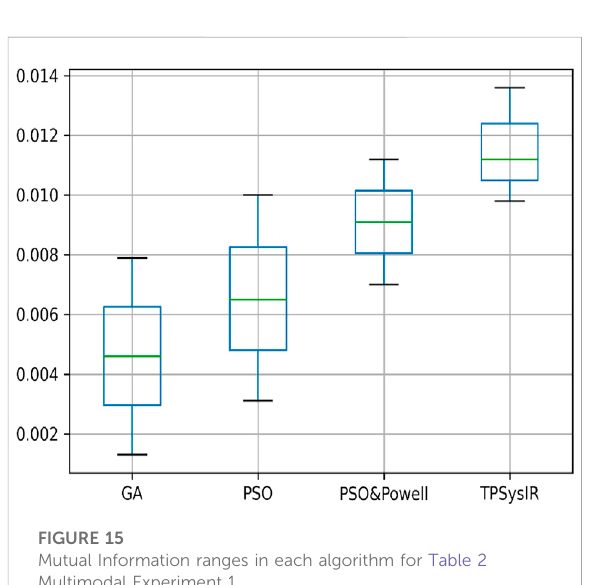
FIGURE 14 Mutual Information ranges in each algorithm for Table 2 single model experiment 2.